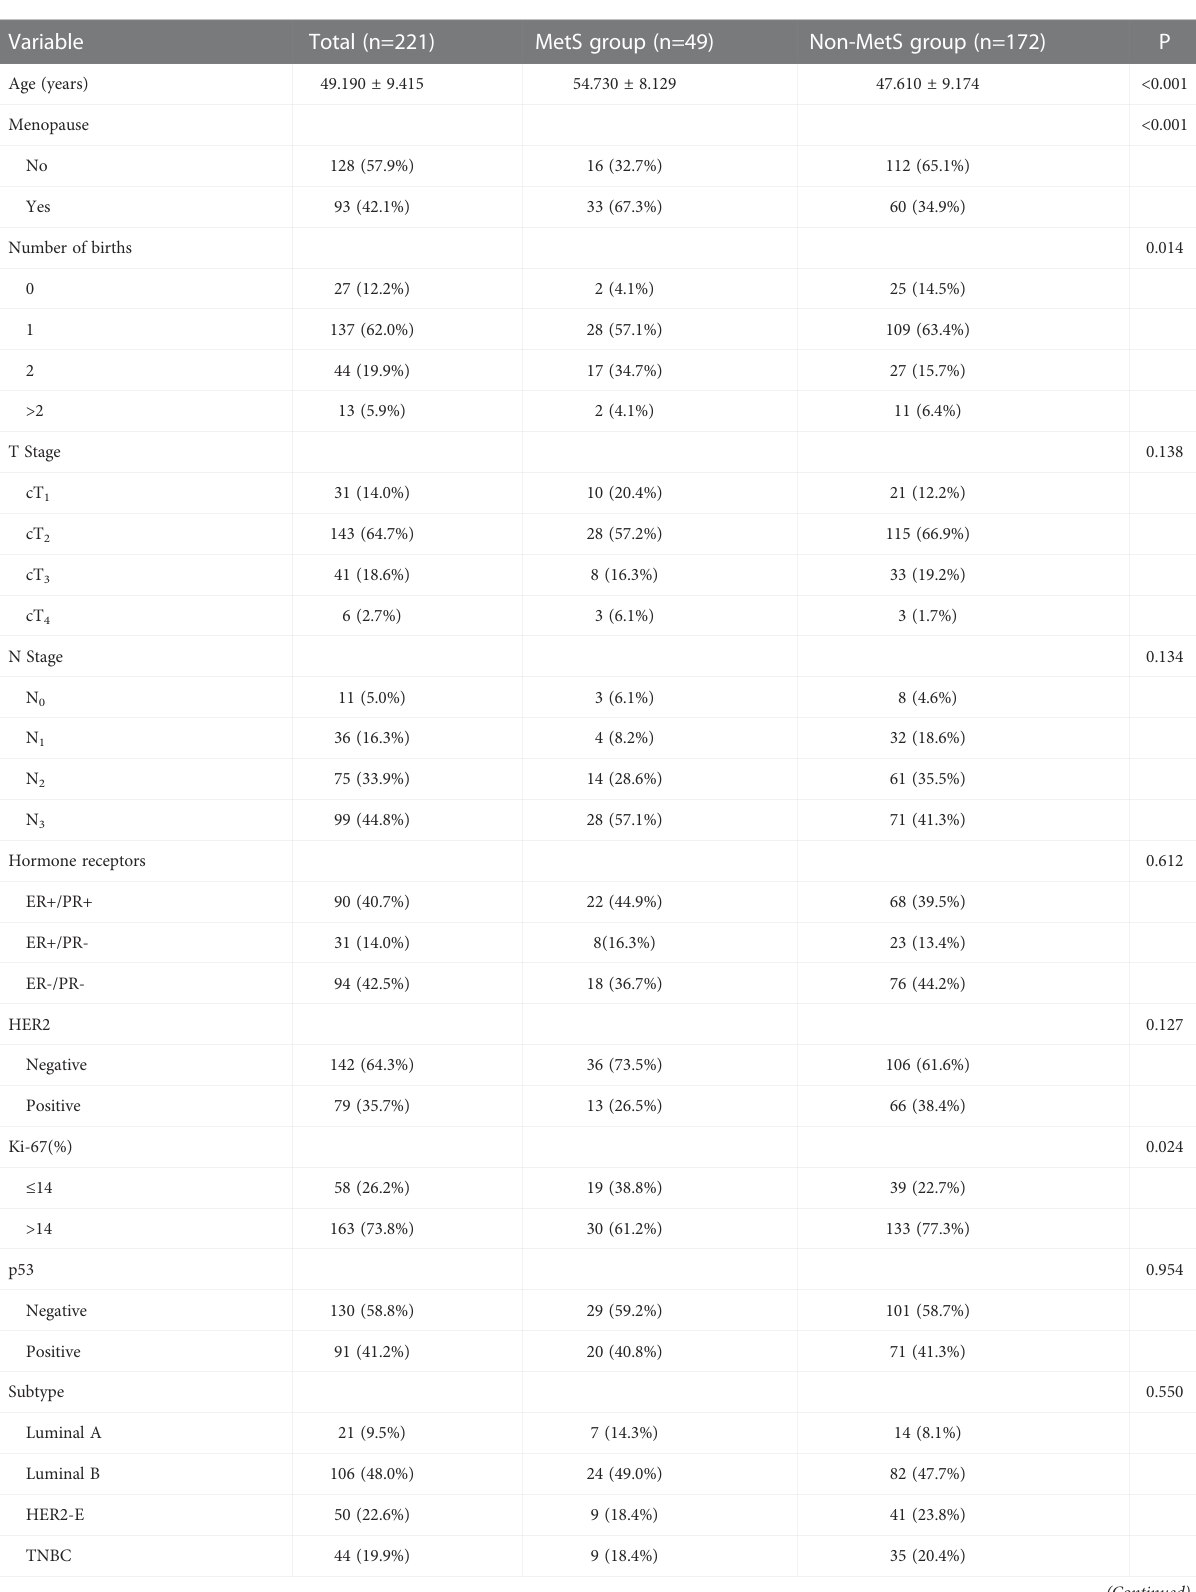
TABLE 1 Patient clinicopathological characteristics by MetS